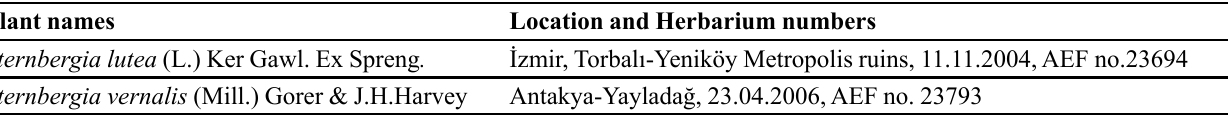
TABLE I - Location and Herbarium numbers of Sternbergia species